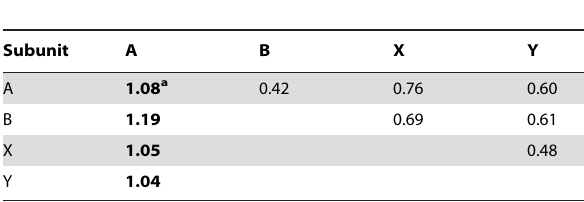
Table 1. Data collection and refinement statistics. Table 2. RMSD values (A˚) among different subunit within NAG bound structure and with the bifunctional mmNAGS/K native